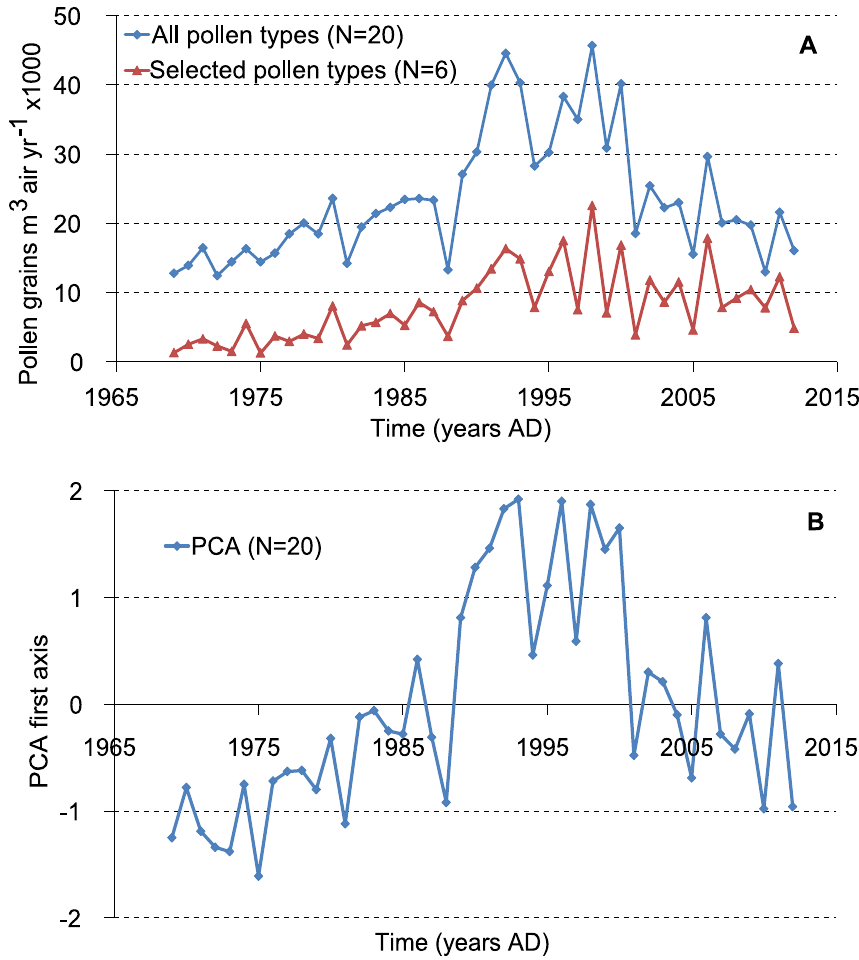
Figure 3. Total annual pollen influx values 1969–2012. (a) Total LUMC pollen influx for all pollen types (n=20) and for selected pollen types (n=6), and (b) sample values of the 1 st PCA axis based on square-root transformed pollen count data.